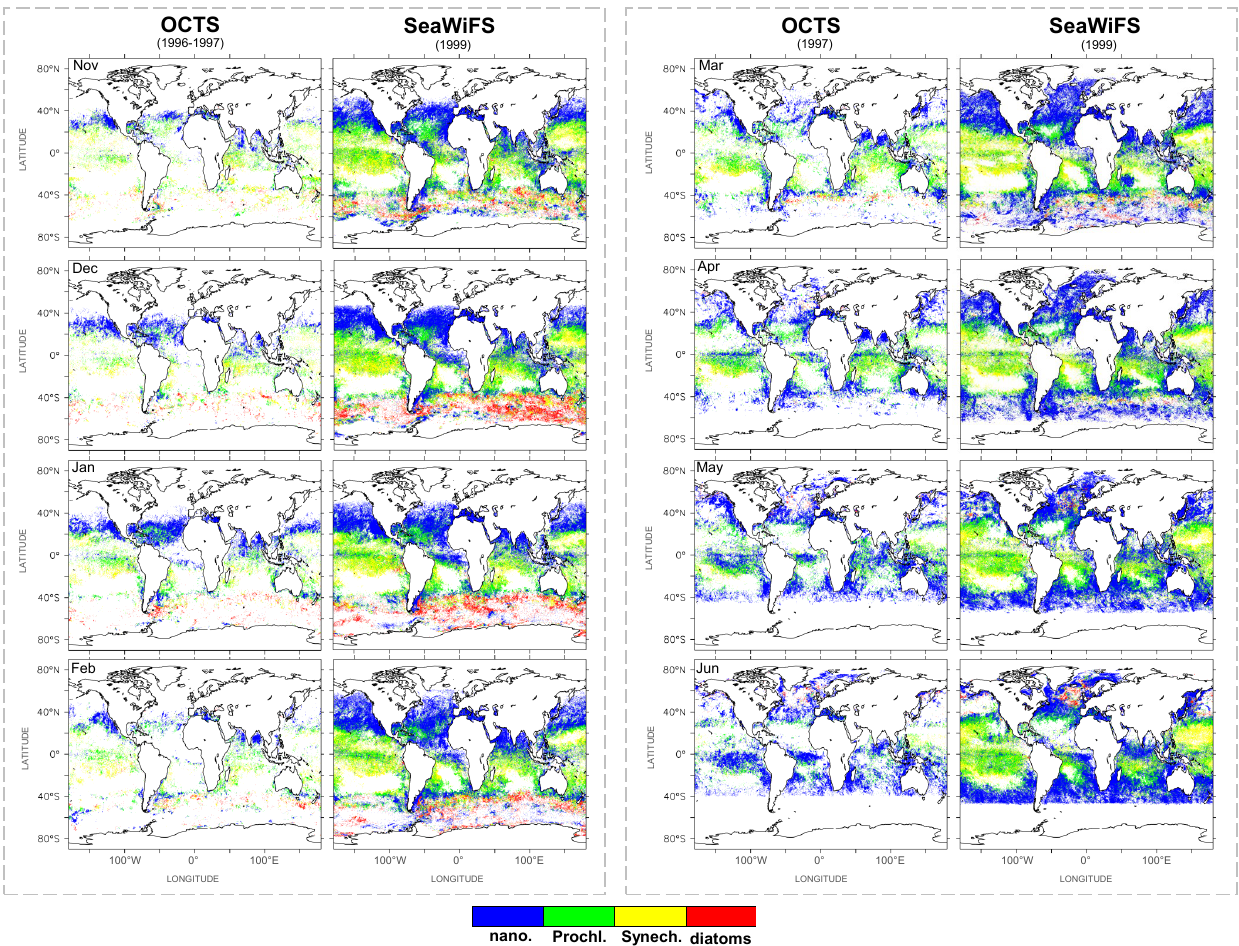
Fig. 3. A comparison between the global distribution each month of the dominant PFT obtained during the early stage of the strong El Ni˜no (1996–1997, OCTS era) and during the La Ni˜na conditions (1999, SeaWiFS era). Phytoplankton group dominance is defined as the group with the largest relative frequency identified by